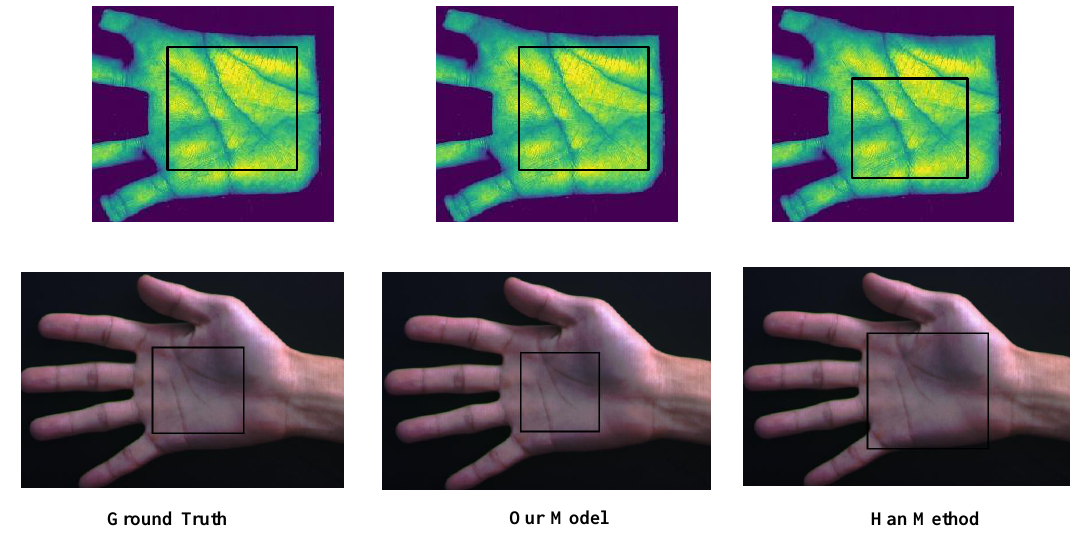
Figure 10. Comparison of extracted palmprint regions with the ground truth ROI.